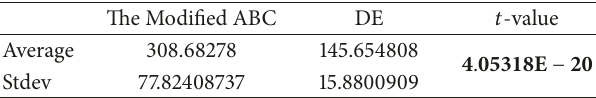
Table 5: The 𝑡 -value for MABC and DE in 49 degrees of freedom is significant at a QoS level of significance by two-tailed 𝑡 -test. The Modified ABC DE 𝑡 -value